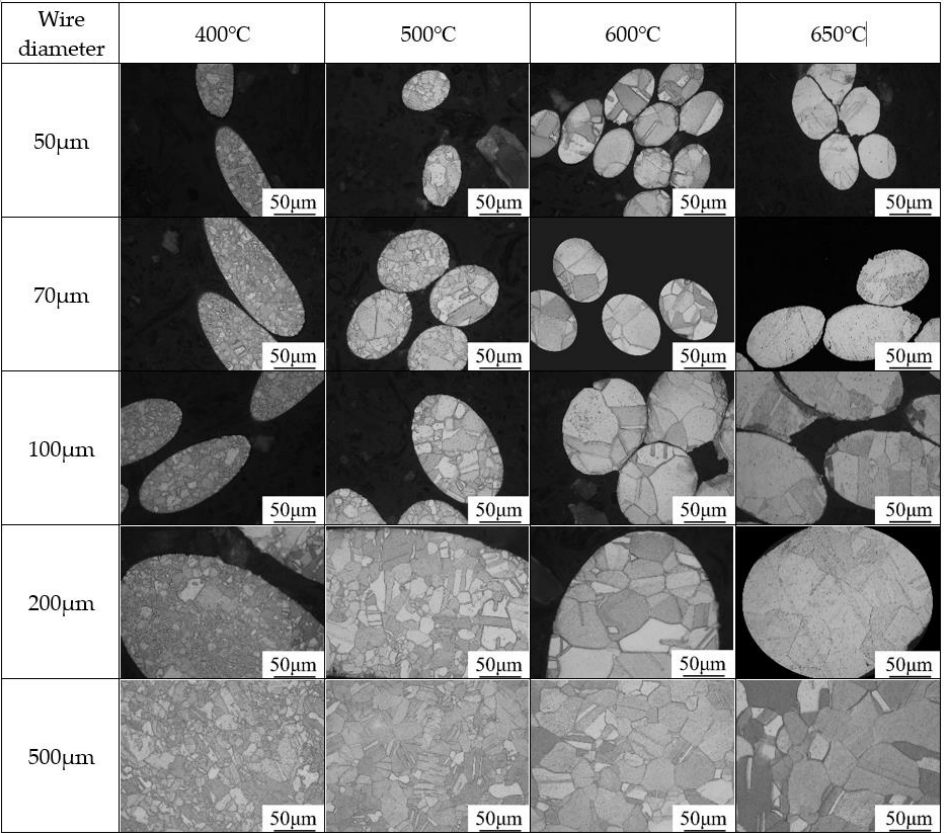
Figure 1. Optical microscopy of specimen with different grain sizes in cross section.